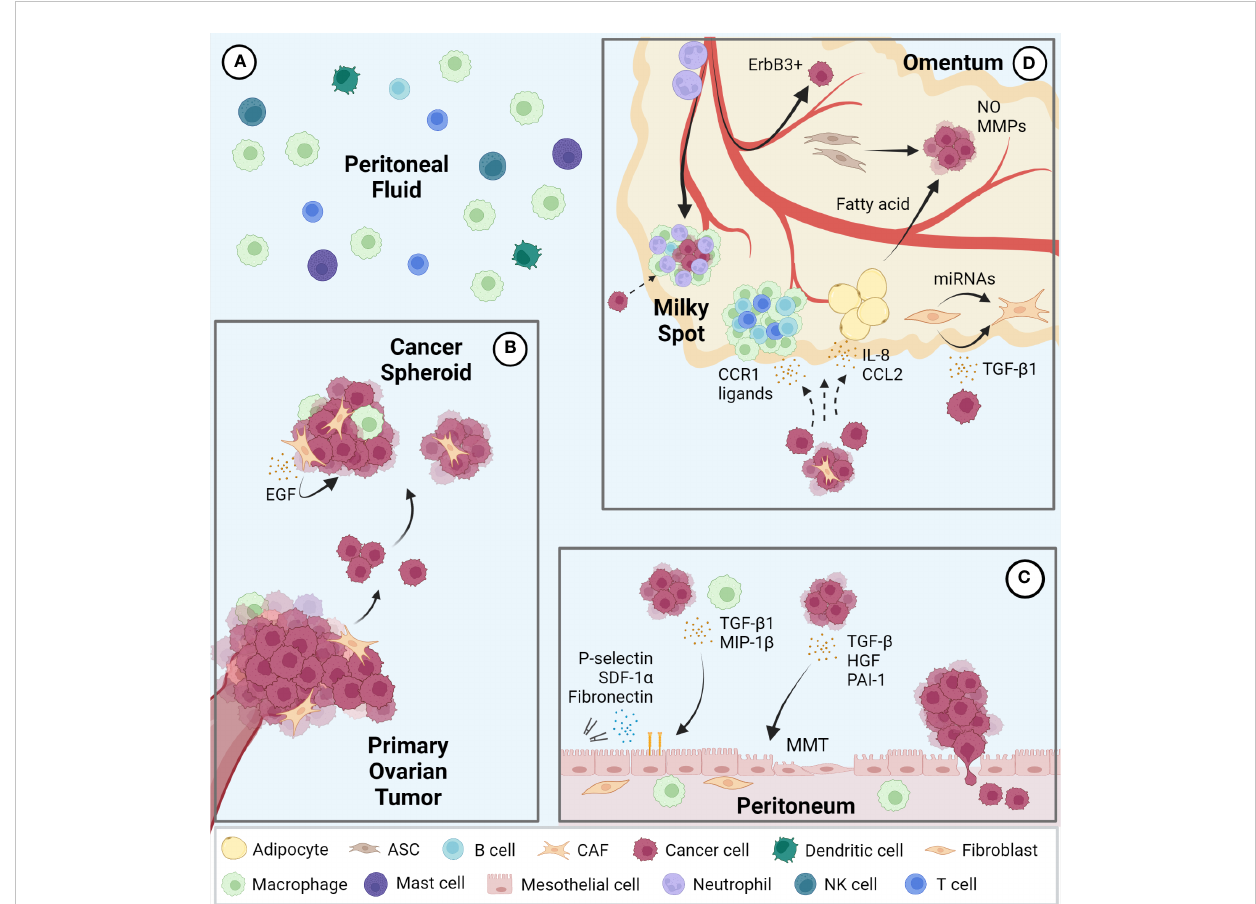
FIGURE 1 Intraperitoneal metastasis of ovarian cancer. (A) Immune cell populations represented in the peritoneal fl uid; macrophages represent the largest population followed by T cells, dendritic cells, mast cells, NK cells, and B cells. (B) Ovarian cancer cells metastasize via detaching from the primary tumor to form multicellular spheroids containing various stromal cells in the peritoneal fl uid and seed in pro-tumor secondary sites including the peritoneum (C) and omentum (D) . EGF, epidermal growth factor; TGF, transforming growth factor; MIP, macrophage in fl ammatory protein; MMT, mesothelial-to-mesenchymal transition; SDF, stromal cell-derived factor; hepatocyte growth factor (HGF); PAI, plasminogen activator inhibitor; CCR, C-C motif chemokine receptor; CCL, C-C motif chemokine ligand; NO, nitric oxide; MMP, matrix metalloproteinase; CAF, cancer associated fi broblasts; ASC, adipose-derived stromal